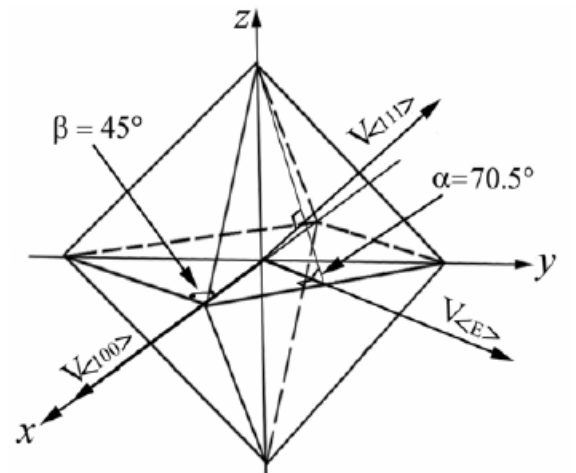
Figure 11. Morphology of primary Si in modified Al-17%Si alloy.